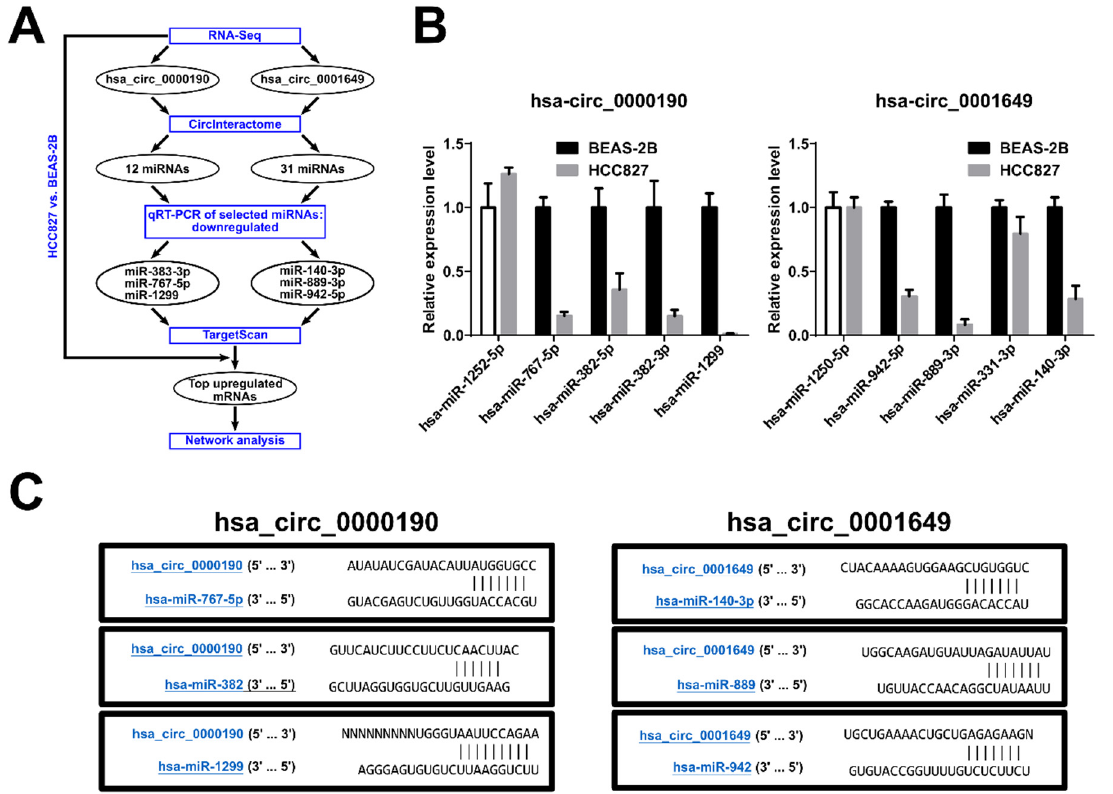
Figure 7. Bioinformatics analysis of potential downstream network for hsa_circ_0000190 and hsa_circ_0001649 in LC. ( A ) Pipeline of analysis. ( B ) qRT-PCR analysis of expression of the selected predicted miRNA targets of hsa_circ_0000190 (left) and hsa_circ_0001649 (right). ( C ) The predicted interaction sites between hsa_circ_0000190, hsa_circ_0001649 and predicted target miRNAs.